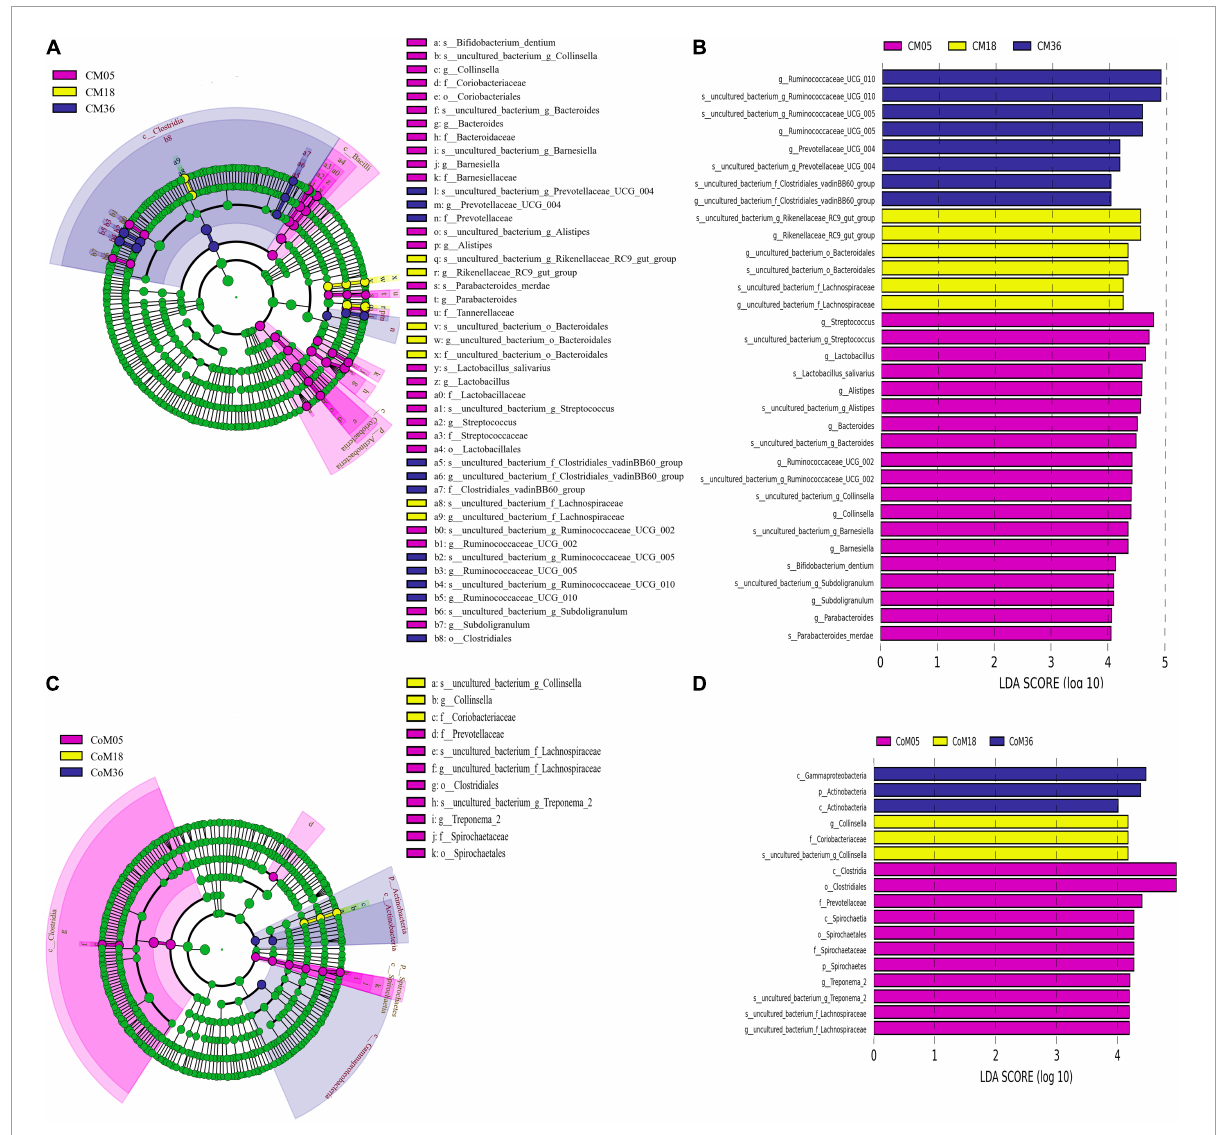
FIGURE3 Linear discriminant effect size (LEfSe) analysis and linear discriminant analysis (LDA) of cecal and colonic microbial. Only taxa meeting an LDA threshold > 4 and p -value threshold < 0.05 are shown in (A) (LEfSe) and (B) (LDA) for cecum and in (C) (LEfSe) and (D) (LDA) for the colon.